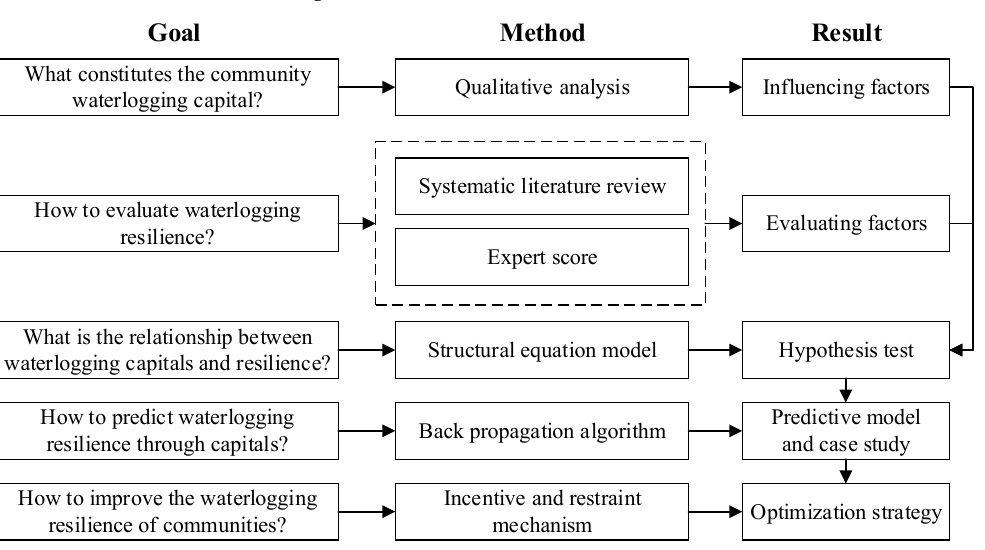
Figure 2. The roadmap of predicting and improving the waterlogging resilience.